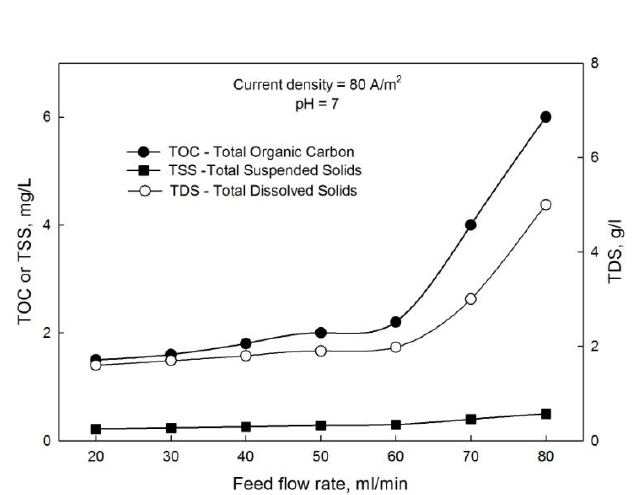
Figure 10. Effect of feed flow rate on residual constituents.